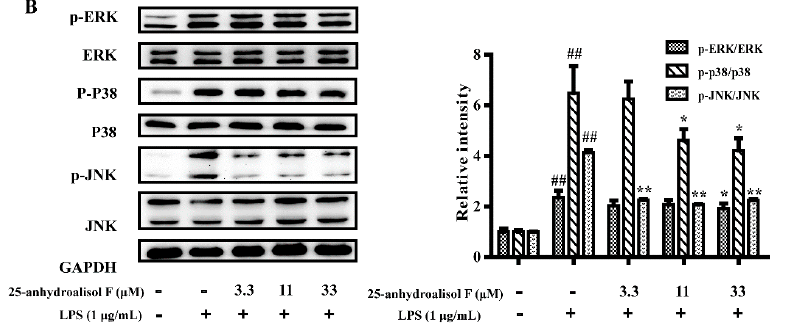
Figure 6. The effect of alisol F and 25-anhydroalisol F on LPS-induced activation of the MAPK signaling pathway. RAW 264.7 cells were pretreated with the different concentrations (0, 3.3, 11 and 33 μ M) of alisol F ( A ) and 25-anhydroalisol F ( B ) for 2 h, then stimulated with or without LPS (1 μ g/mL) for 30 min. The expressions of phospho-ERK1/2, ERK1/2, phospho-p38, p38, phospho-JNK, and JNK proteins were analyzed by Western blot. The data represent the means ± S.E. of three independent experiments. ( ## p < 0.001 vs. control group; * p < 0.05; ** p < 0.001 vs. LPS group).